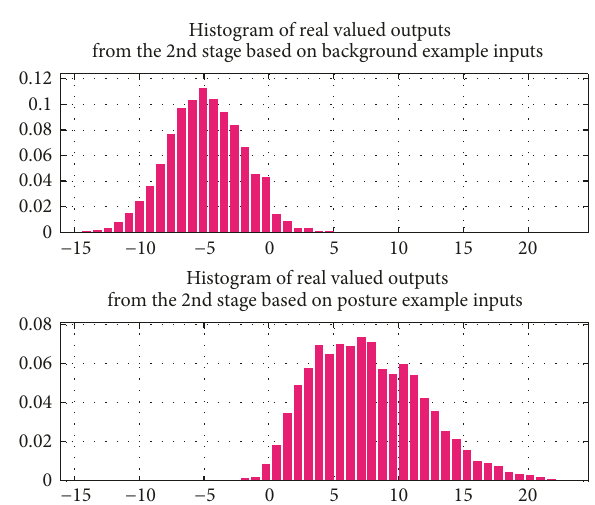
Figure 5: Histograms of output values from R 2 (⋅) in the second stage of SftB classifier. The upper one is calculated from the background examples and the bottom one is from the hand posture